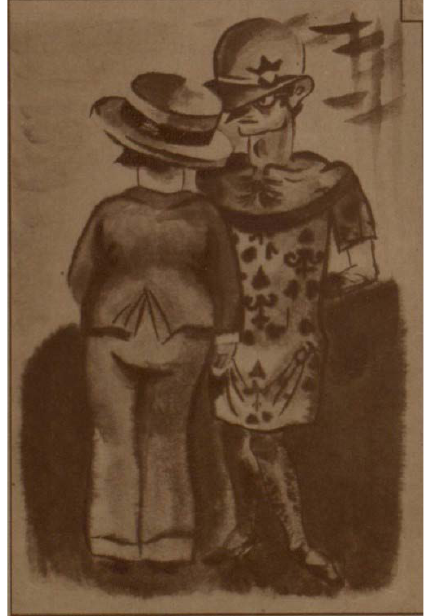
Figure 2. ‘Moga mobo fuku no torikae’ [Moga Mobo Clothes Swap], Asahi Gurafu [Asahi Graphic], 1928, vol. 11, no. 10: